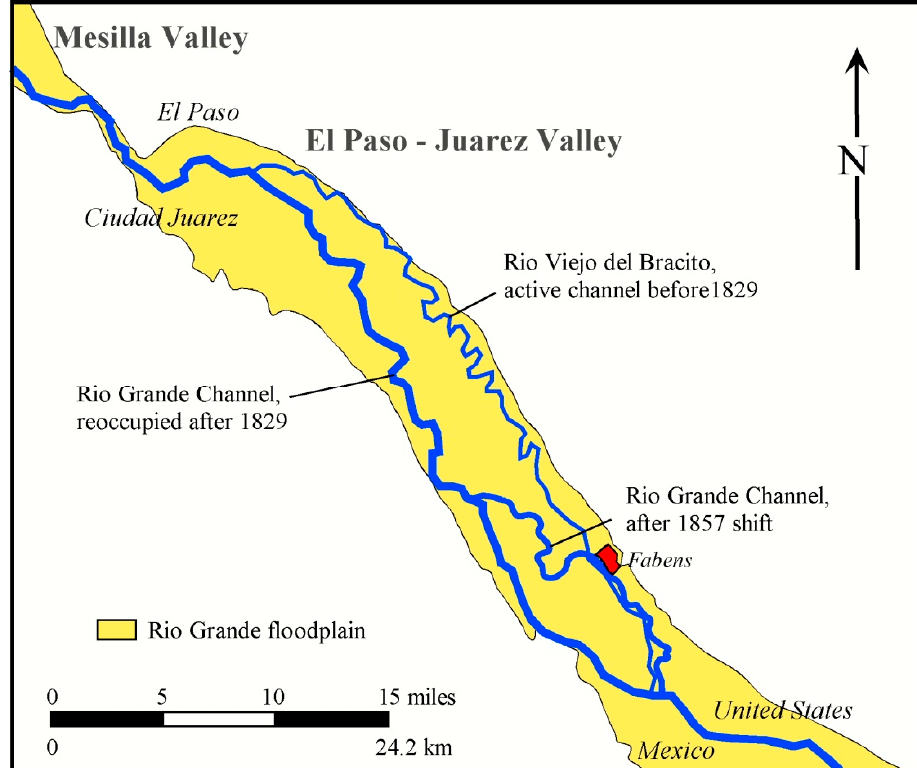
Figure 11. A channel avulsion places the active Rio Grande channel near Fabens prior to 1829. Hall and Peterson [38] called the channel the Rio Viejo del Bracito. The Rio Grande channel, close to its present day location, was reoccupied in 1829 before the subsequent Fabens channel avulsion occurred in 1857. This places pre-dam water near Fabens for extended periods of time prior to permanent channel rectification. Figure modified from Hall and Peterson [38]. Pre- and-post 1829 channel delineation from Hall and Peterson [38] and 1857 channel delineation from IBWC [36].